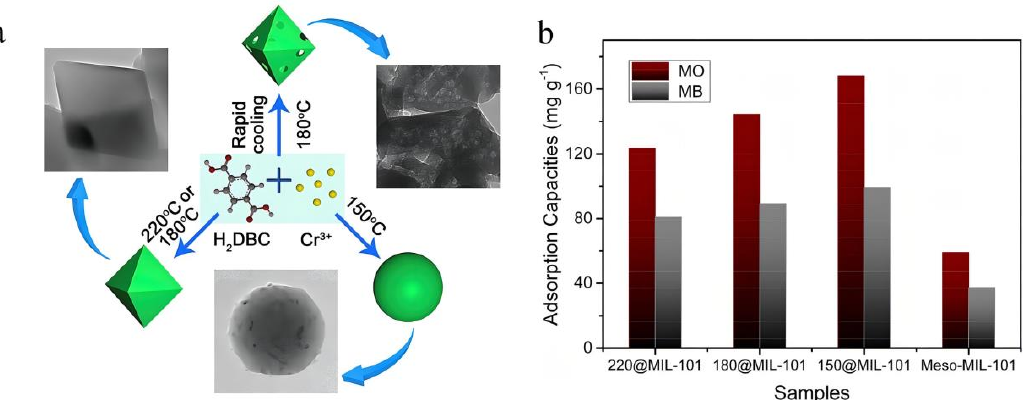
Figure 10. ( a ) Synthetic scheme of different morphologies of MIL-101(Cr) crystal. ( b ) Adsorption performance comparison of samples in MO (200 mg L −1 ) and MB (200 mg L −1 ) solution at neutral medium [107]. Reprinted from ref. [107]. Copyright © 2022, with permission from Elsevier.